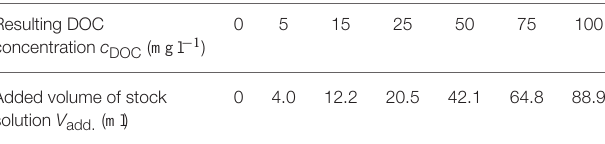
TABLE 1 | Volume of stock solution added to V = 0.8 l zero solution to produce several DOC